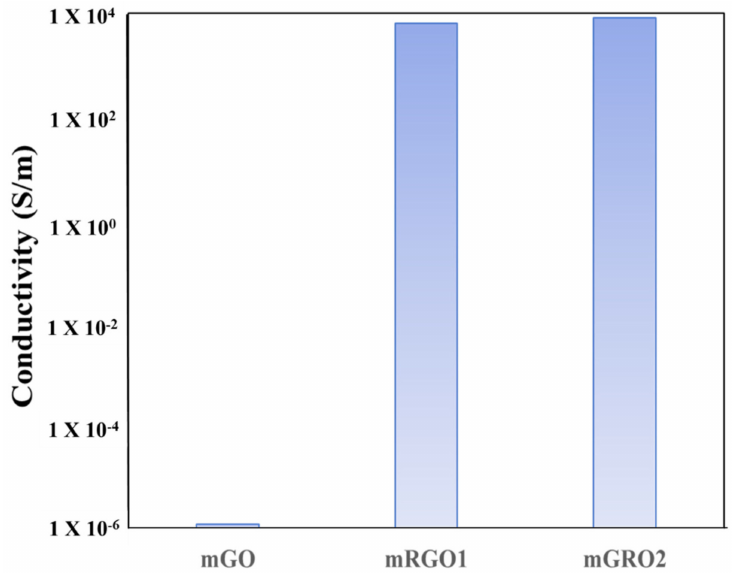
Figure 4. Electrical conductivity of mGO, mRGO1 and